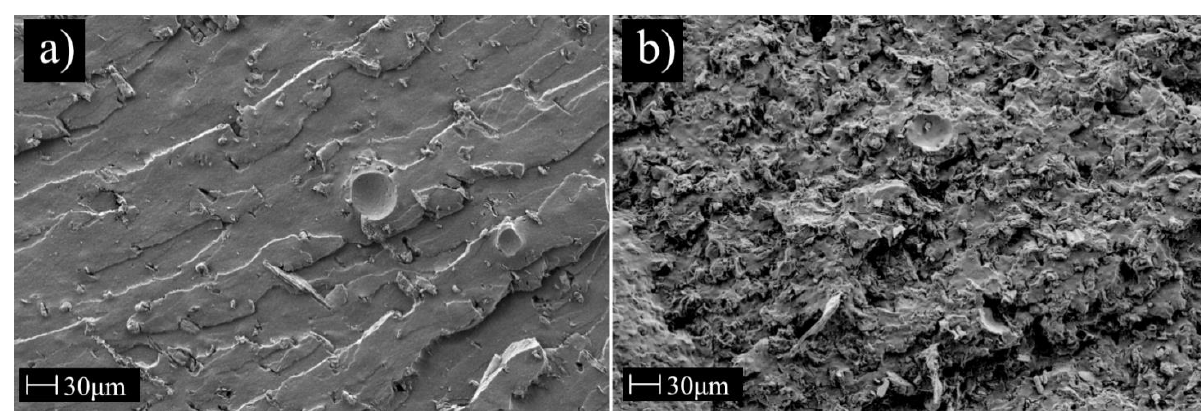
Figure 6. FESEM micrographs taken from the fracture surface of H2 composites created during tensile testing with filler content of a) 4 % and b) 16 %.